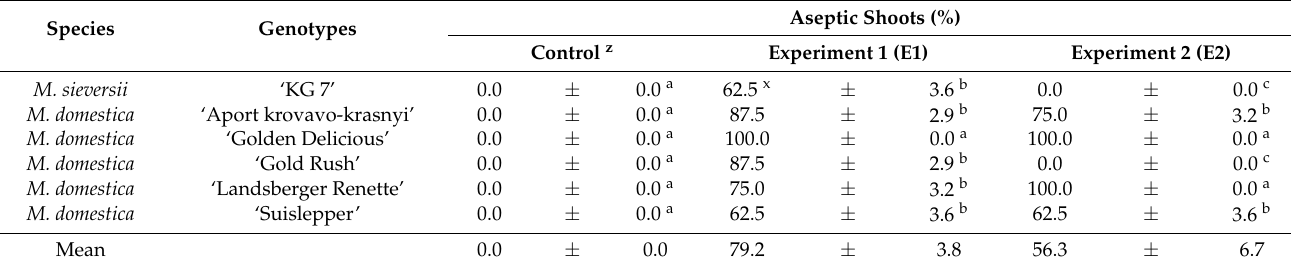
x Data represent mean ± standard error (SE). z Controls comprising shoot segments were excised from six-week- old cultures with the presence of bacteria and cultured on basal medium without PPM TM for three passages of 6 weeks each (total of 18 weeks of culture). Values followed by different letters within each section were significantly different at p ≤ 0.05 using Tukey’s mean separation